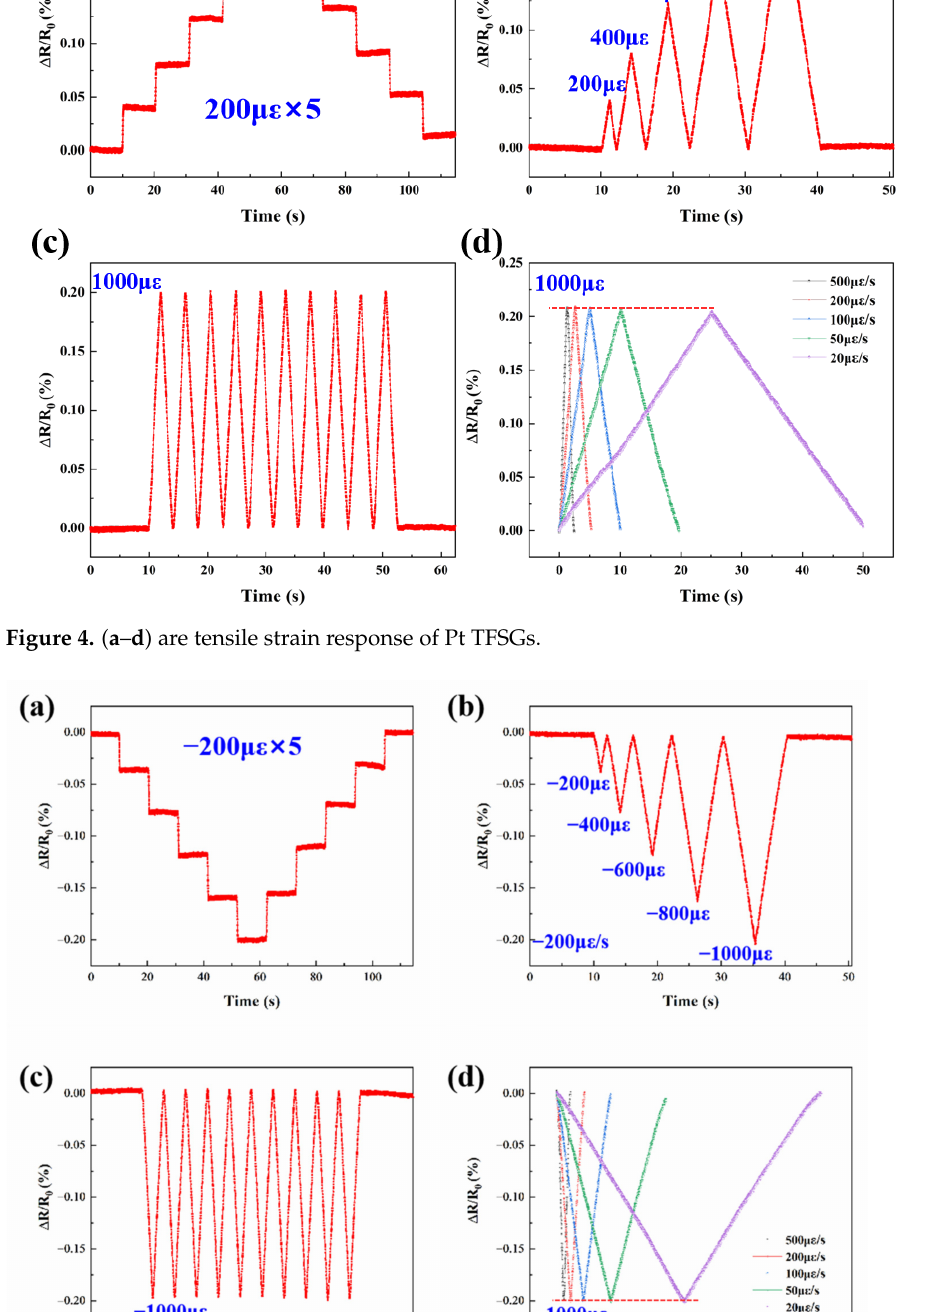
Figure 5. ( a – d ) are compressive strain response of Pt